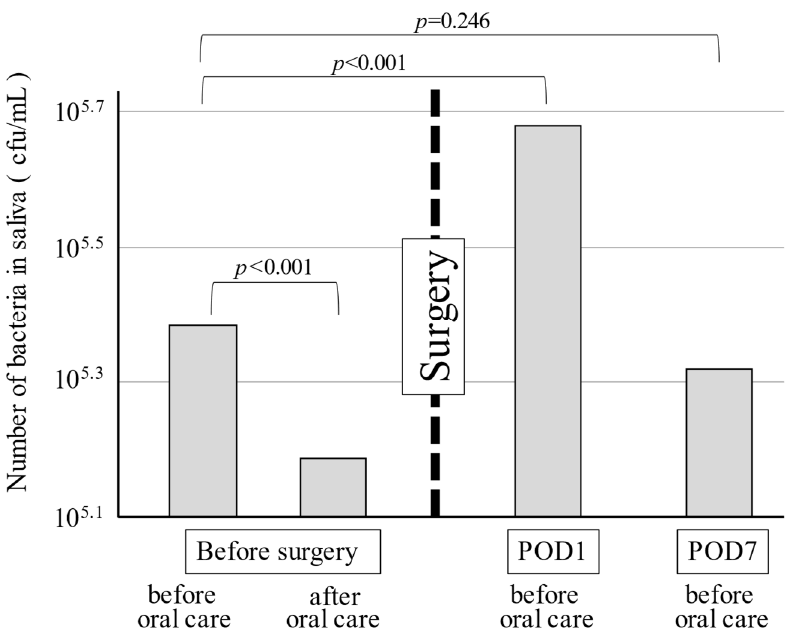
Figure 1. The number of bacteria in saliva during the perioperative period.